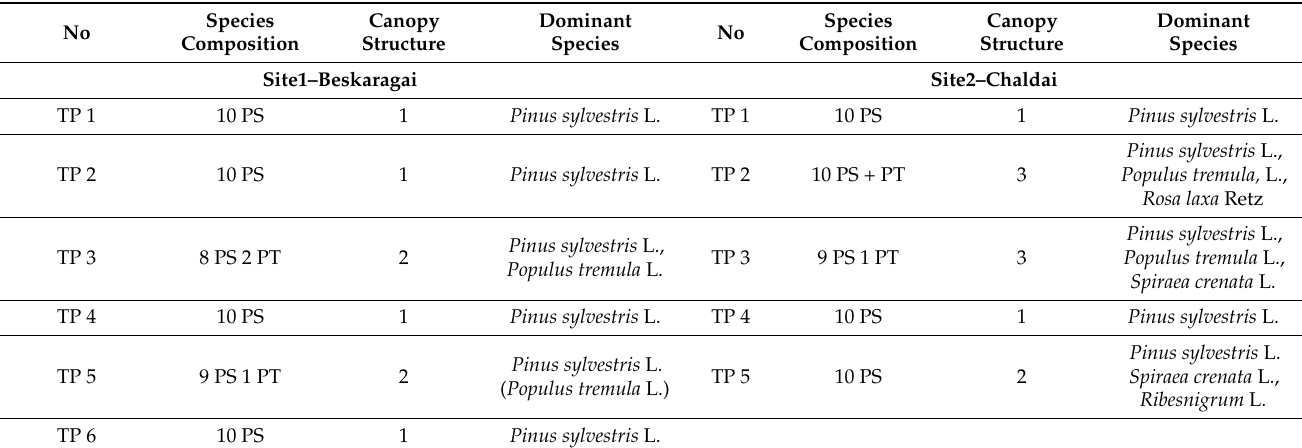
Table 3. Layered structure and species composition of forest stands (PS– Pinus sylvestris , PT–Populus tremula, BP–Betula